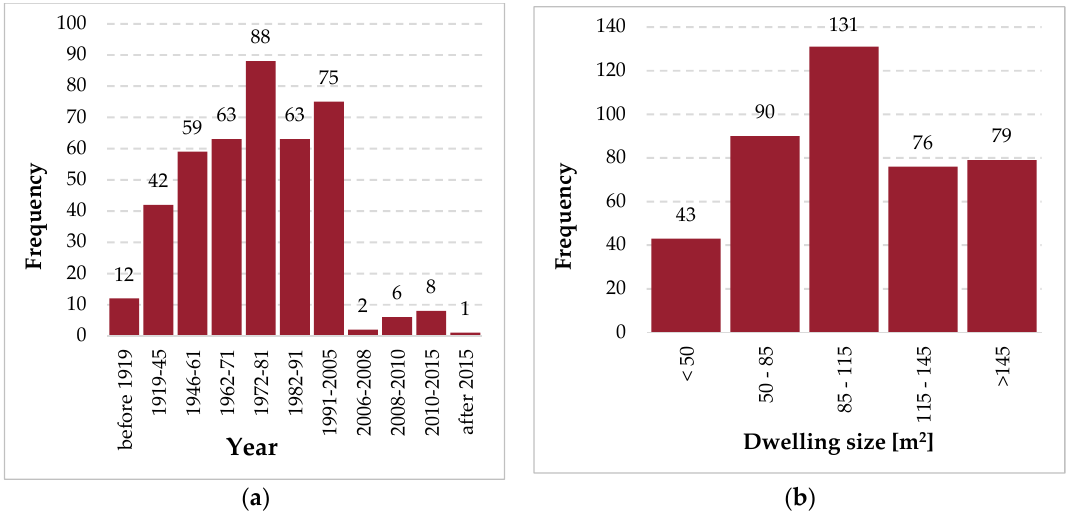
Figure 1. Dwellings’ subdivision: ( a ) construction year; ( b ) size.